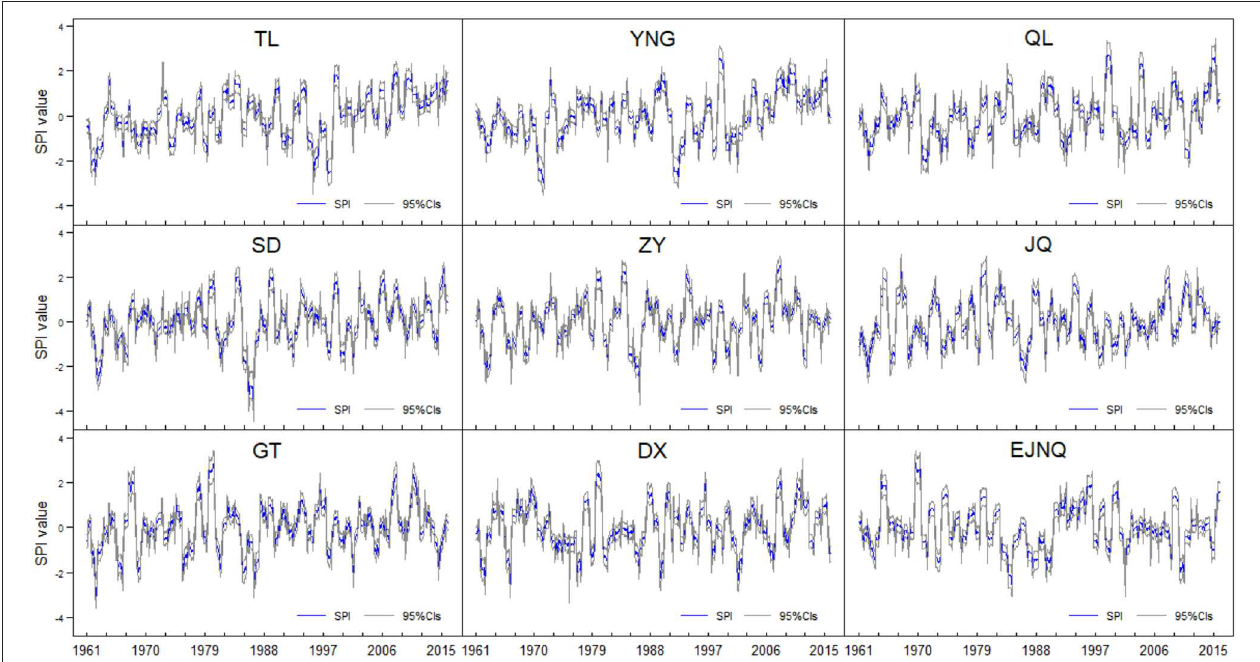
FIGURE 8 | SPI values and their 95% CIs estimations considering the parameter estimation errors (the abbreviated names of stations are the same as in Figure 3 ).